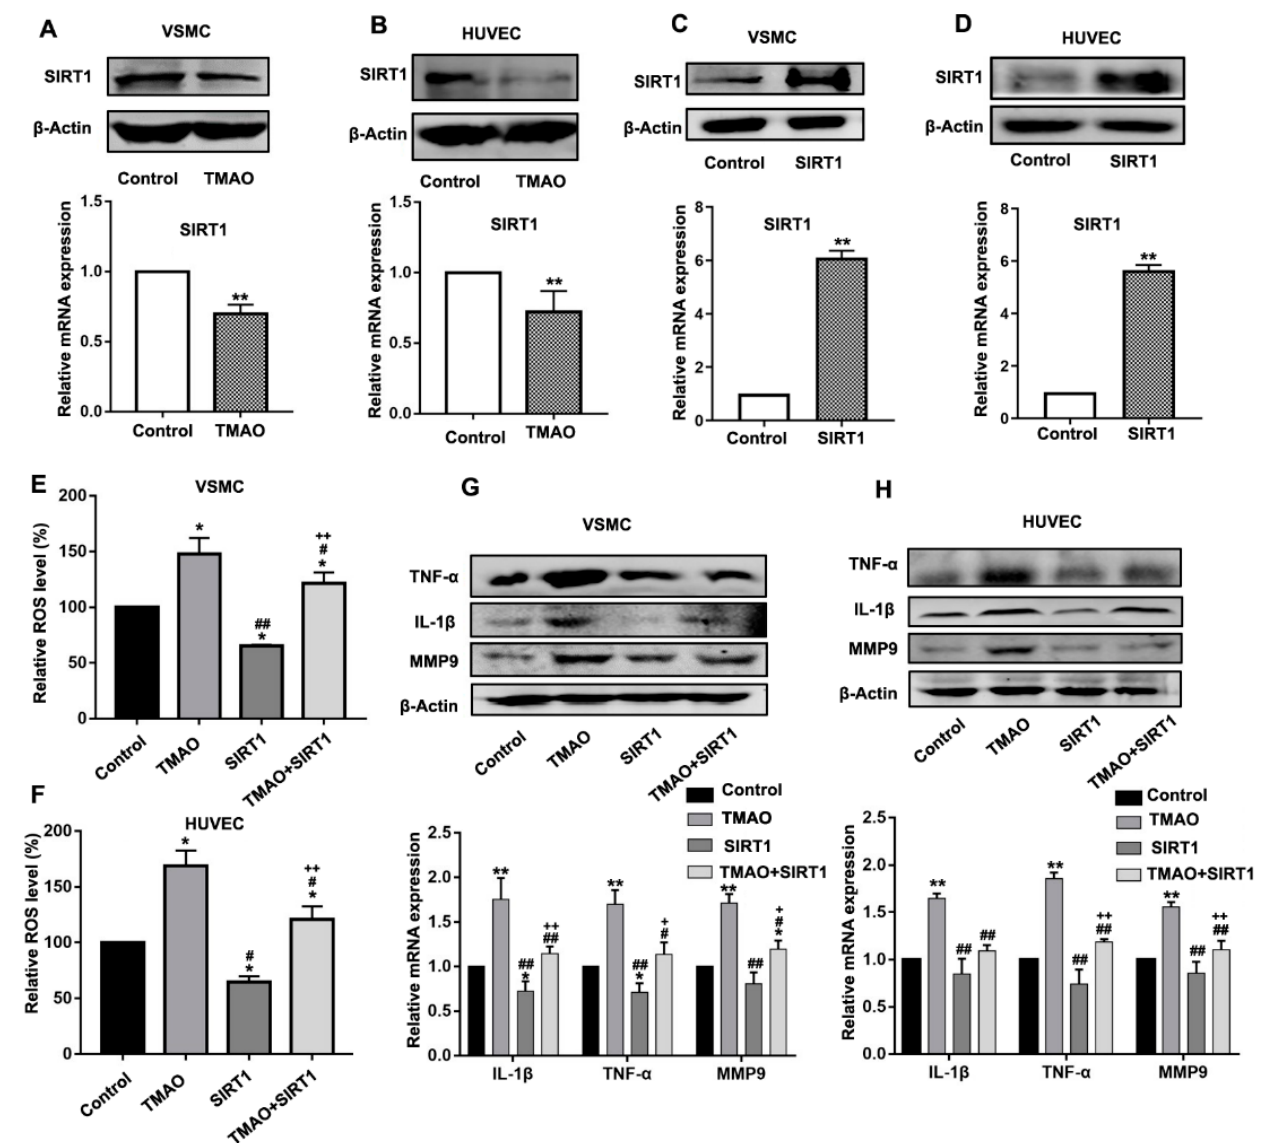
Figure 2. TMAO increased the ROS level and inflammatory factors by inhibiting SIRT1 expression. ( A – D ).The protein level (upper panels) and transcript level (lower panels) of SIRT1 were determined in VSMCs ( A , C ) and HUVECs ( B , D ) treated with 1000 µ M TMAO ( A , B ) and transfected with pCMV- Tag 2B- SIRT1 plasmid ( C , D ) for 24 h by western blot and quantitative real-time PCR. ( E , F ) VSMCs ( E ) and HUVECs ( F ) were treated with 1000 µ M TMAO, SIRT1 vector and 1000 µ M TMAO plus SIRT1 vector. The total ROS levels were determined using fluorescence intensity of DCFH-DA staining by flow cytometry. ( G , H ) The protein level (upper panels) and transcript level (lower panels) of inflammation-related markers IL-1 β , TNF α , MMP9 were determined in VSMCs ( H ) and HUVECs ( F ) treated with 1000 µ M TMAO, SIRT1 vector and 1000 µ M TMAO plus SIRT1 vector for 24 h. Values are the mean ± SD; n = 3; two-way ANOVA followed by a Tukey post hoc test. * p < 0.05; ** p < 0.01 vs. Control; # p < 0.05; ## p < 0.01 vs. TMAO group; + p < 0.05; ++ p < 0.01 vs. SIRT1 group. Furthermore, the expression of major inflammatory cytokines TNF α , IL-1 β and MMP9 were all inhibited in VSMCs and HUVECs when SIRT1 was overexpressed (Figures 2G,H and S2E,F). These results indicate that SIRT1 is an upstream mediator causing TMAO- induced ROS production and inflammatory